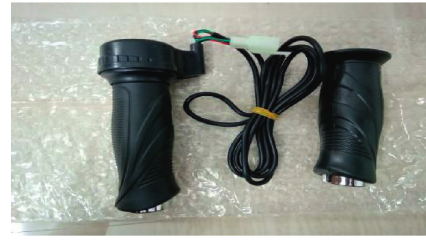
Figure 6: Model of the throttle.